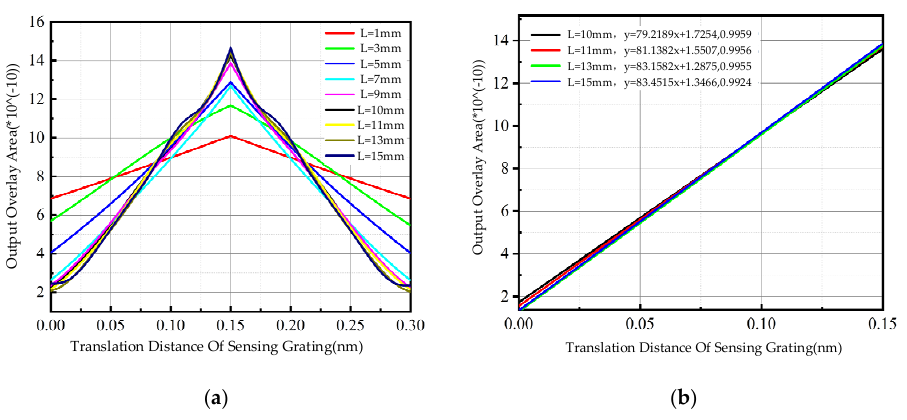
Figure 4. ( a ) Variation in spectral superposition area with the translation distance of sensing grating at different gate region lengths. ( b ) Linear fitting of the superimposed area on the left side of the curve at L = 10 mm, 11 mm, 13 mm, and 15 mm.